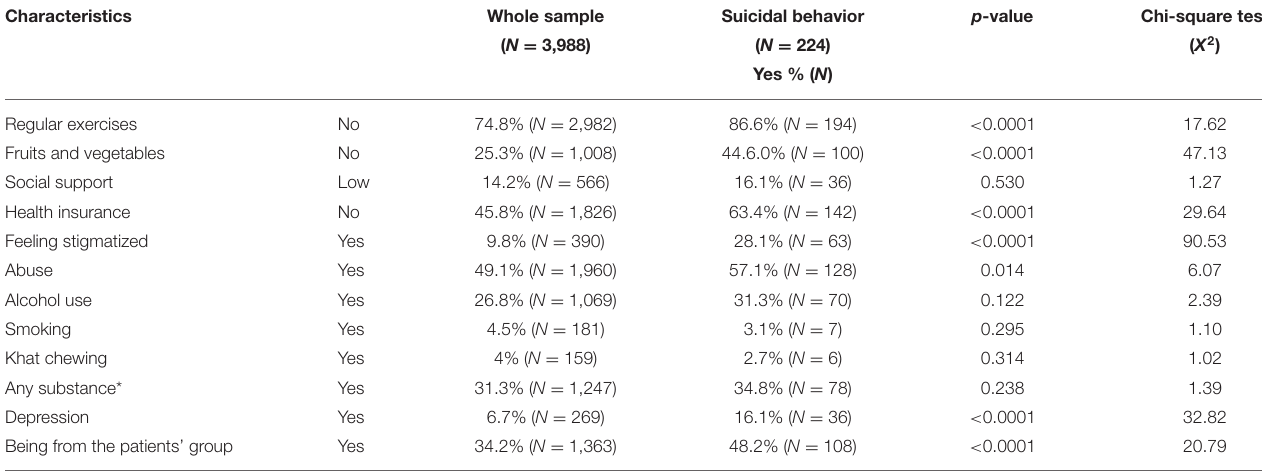
TABLE 2 | Bivariate comparison of participants psychosocial and medical characteristics in relation to having YES or NO suicidal behavior.